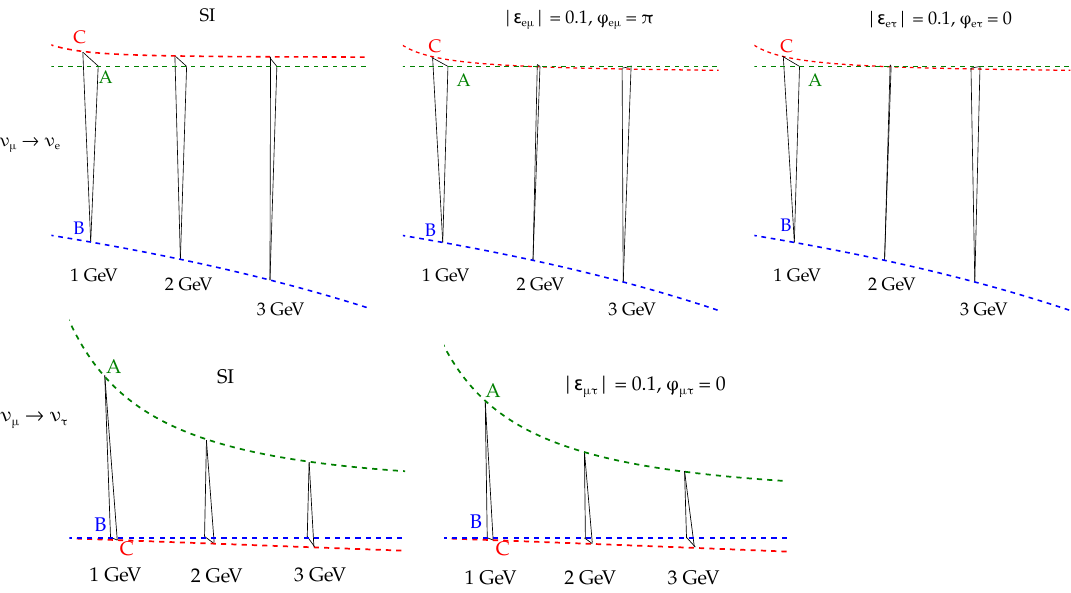
Figure 5 . Evolution of the LUT for the ν µ → ν e (top row) and ν µ → ν τ channel (bottom row). The green, blue and red dashed lines show the evolution of the three vertices A , B and C with the energy for the standard case (left) and the NSI case (middle and right